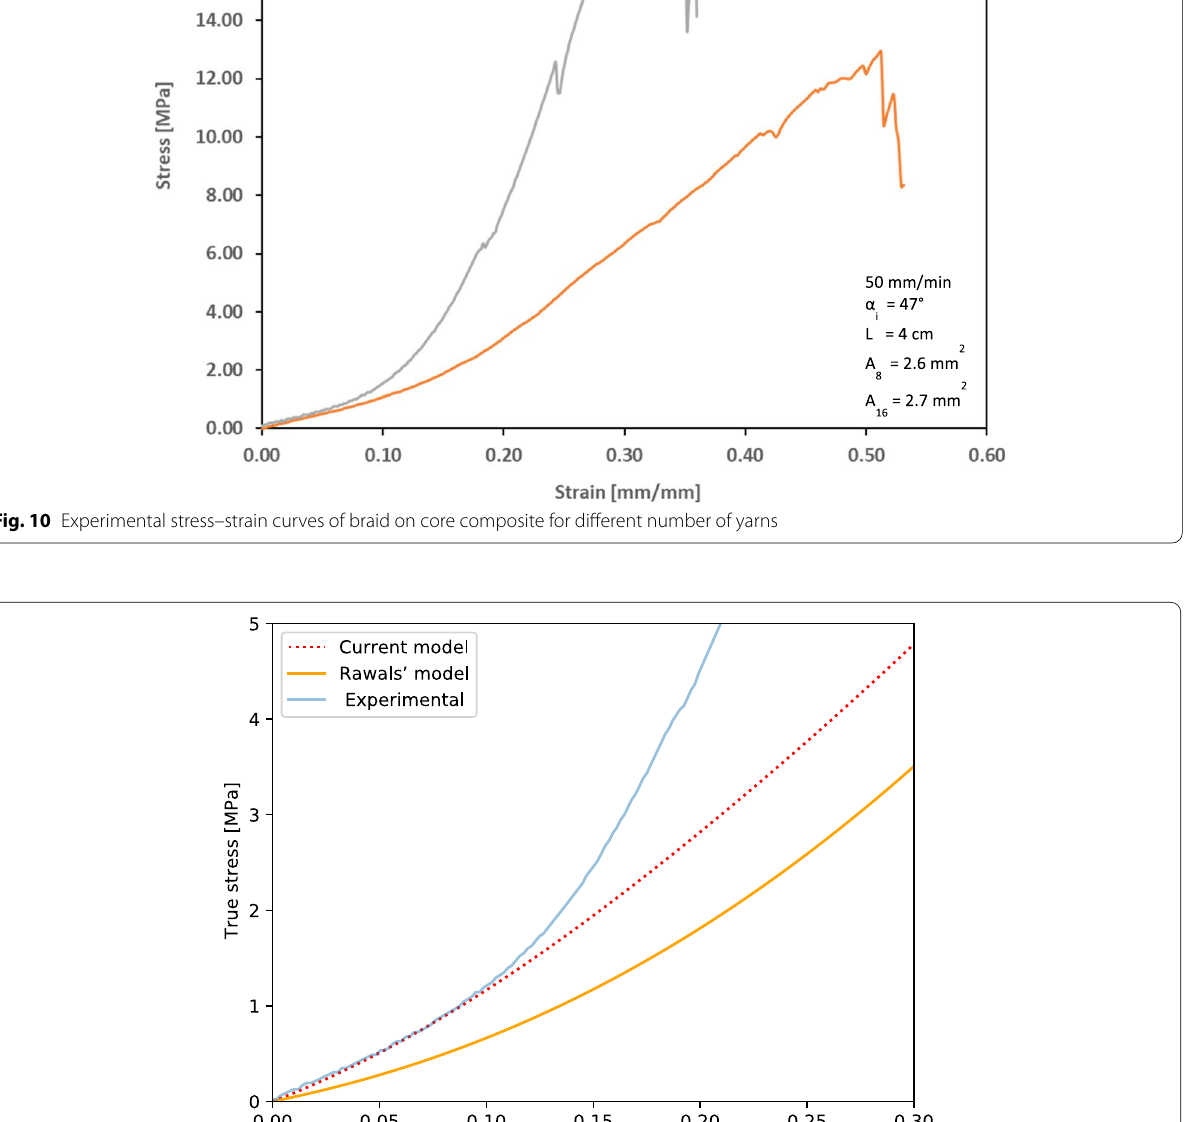
Fig. 11 True stress versus true strain for the current model, Rawals model, compared to experimental results for α i